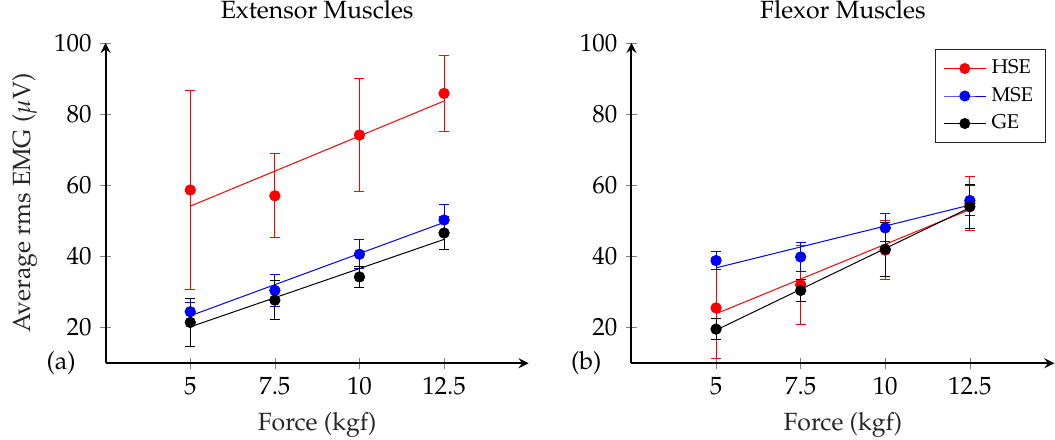
Figure 6. Surface electromyography against grip force measured with hand-sewn electrodes (HSE), machine-sewn electrodes (MSE) and gel electrodes (GE) for a typical participant, tested on the participant’s: (a) extensor muscle group; and (b) flexor muscle group. Reported are mean values over five